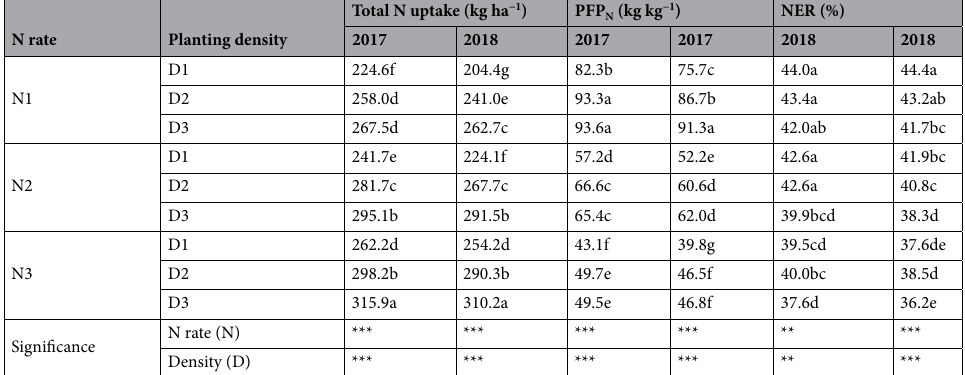
Table 4. The total N uptake, partial factor productivity of applied N (PFP N ), and nitrogen efficiency ratio (NER) in 2017 and 2018. ns no significant difference. Means within a column followed by the different letters are significantly different at P < 0.05. N is N rate, and D is planting density. The three N rates are 120 (N1), 180 (N2), and 240 (N3) kg ha −1 . The three planting density levels are 60,000 (D1), 75,000 (D2), and 90,000 plants ha −1 (D3). **Significance at the P < 0.01 level. ***Significance at the P < 0.001